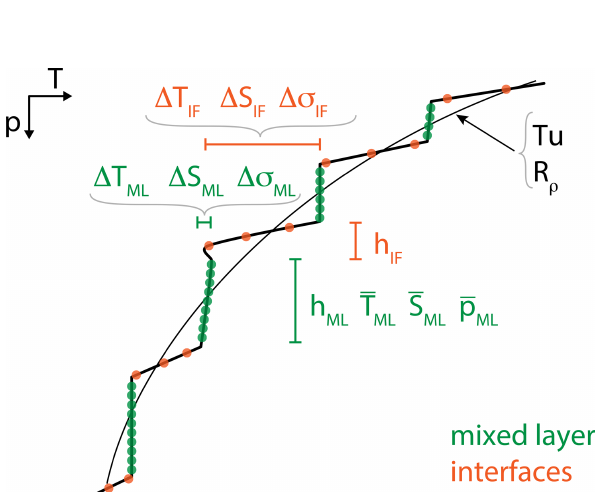
Figure 3. Schematic of a typical temperature profile with staircases, indicating the definitions of the quantities used to detect the thermo- haline staircases (green: mixed layer; orange: